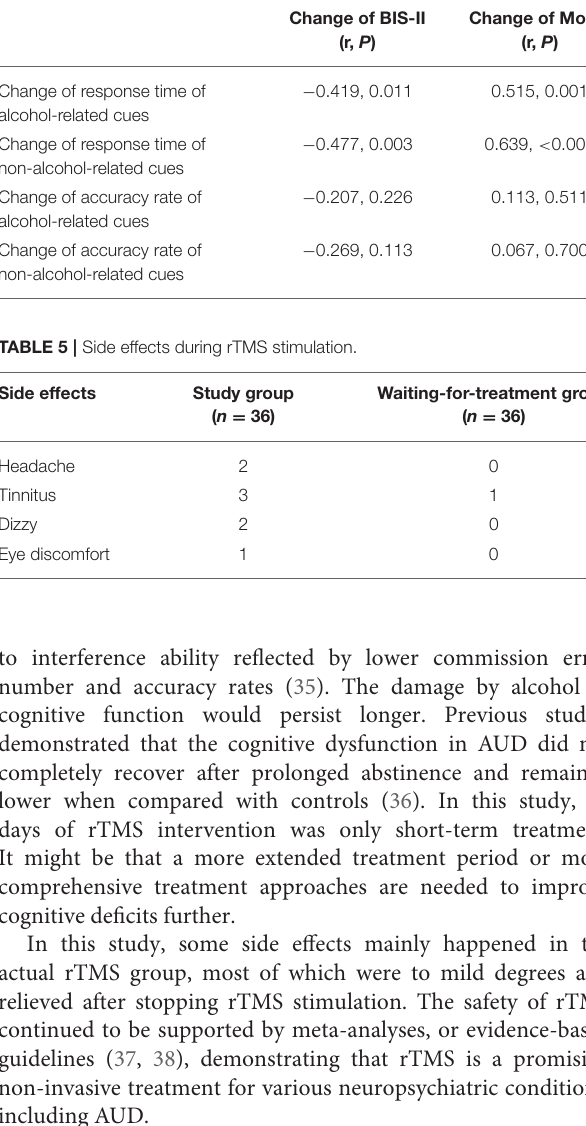
Change of BIS-II Change of MoCA (r, P ) (r, P )